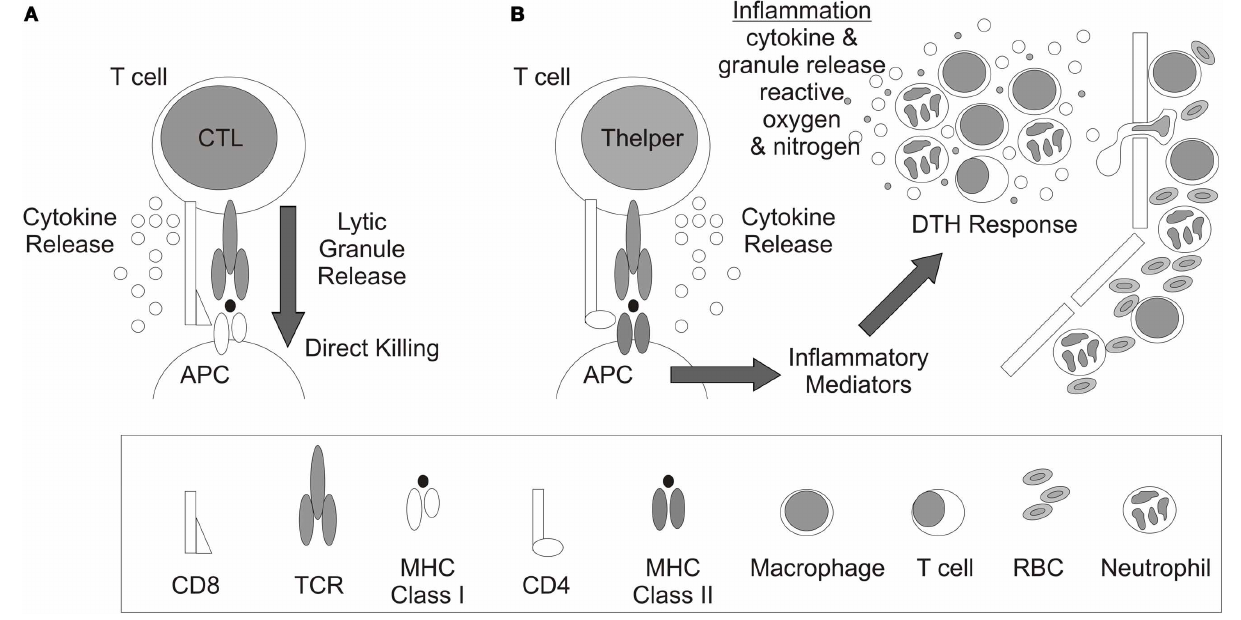
FIGURE 2 | T cell recognition and response. Antigen recognition and response by (A) CD8 + cytolytic T lymphocytes (CTL) and (B) CD4 + T helper cells. Antigen presenting cell (APC), cluster of differentiation (CD), delayed type hypersensitivity response (DTH), T cell receptor (TCR), major histocompatibility complex (MHC), and red blood cell